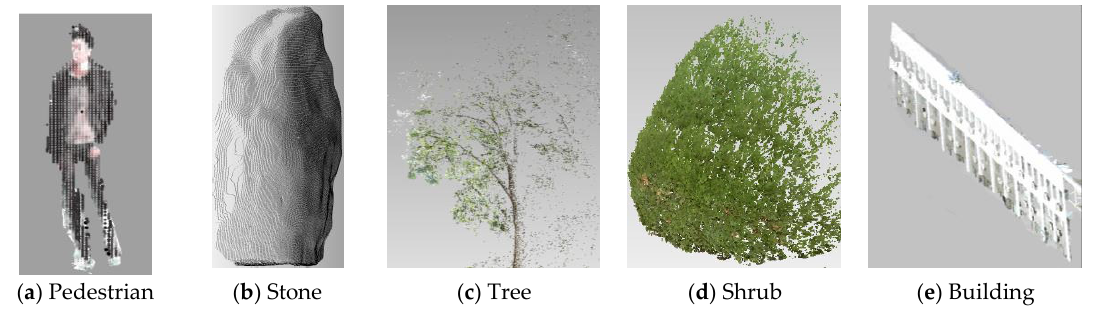
Figure 12. Semantic segmentation of independent objects in Scene A ( a ) and Scene B ( b ).